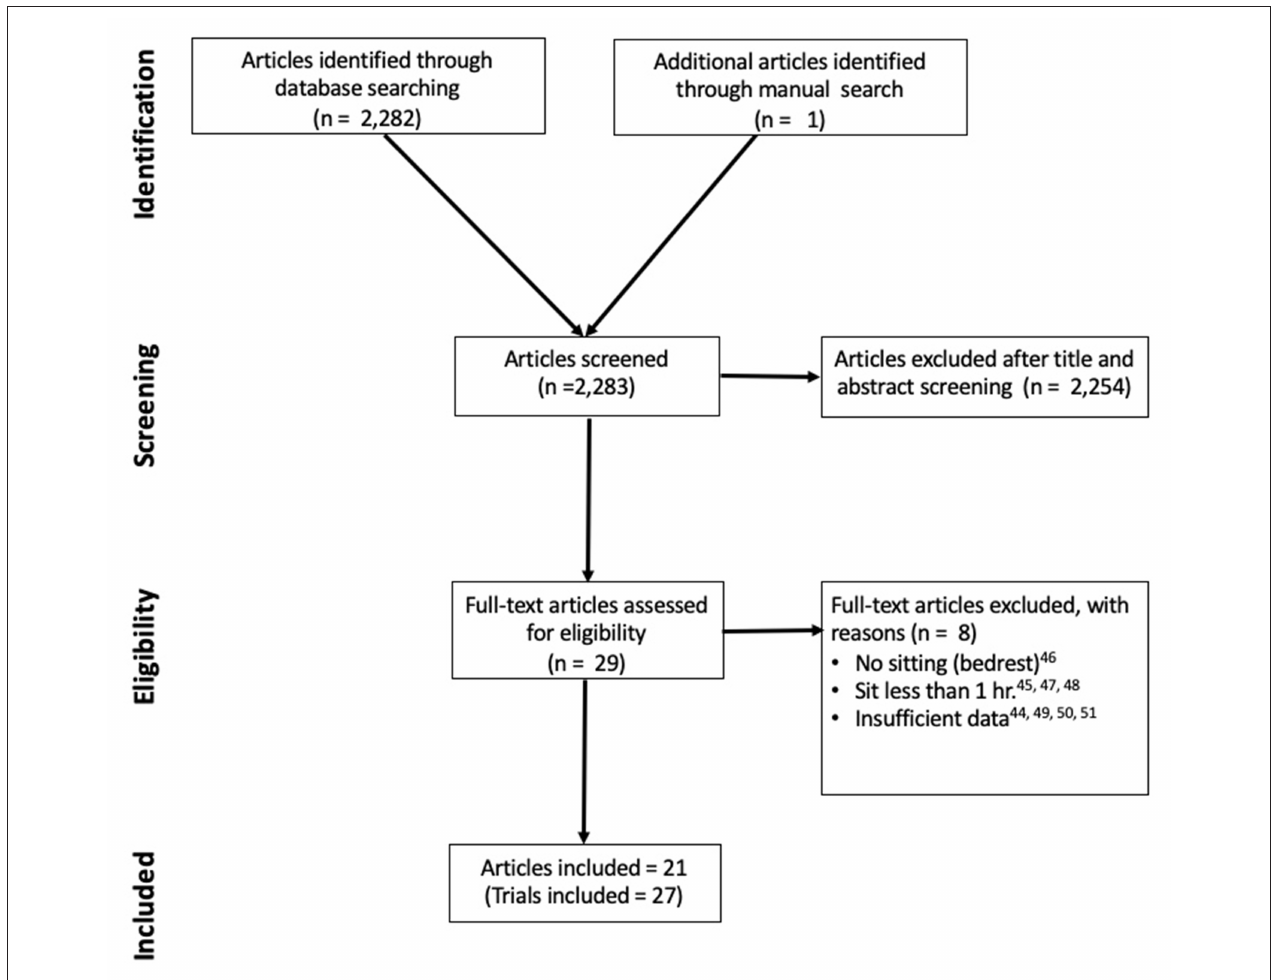
FIGURE 1 | Flow chart including inclusion and exclusion criteria. hr,